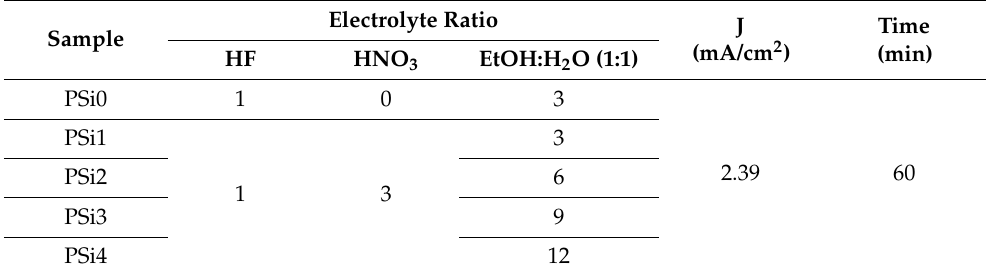
Table 1. Samples